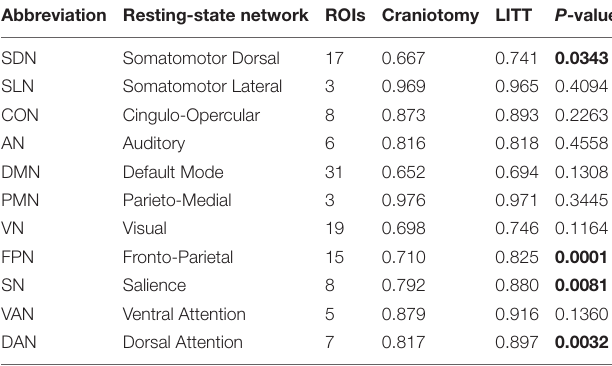
TABLE 2 | Resting-state networks and group-wise two-dimensional correlation coefficients between pre-operative and post-operative scans. Abbreviation Resting-state network ROIs Craniotomy LITT P -value